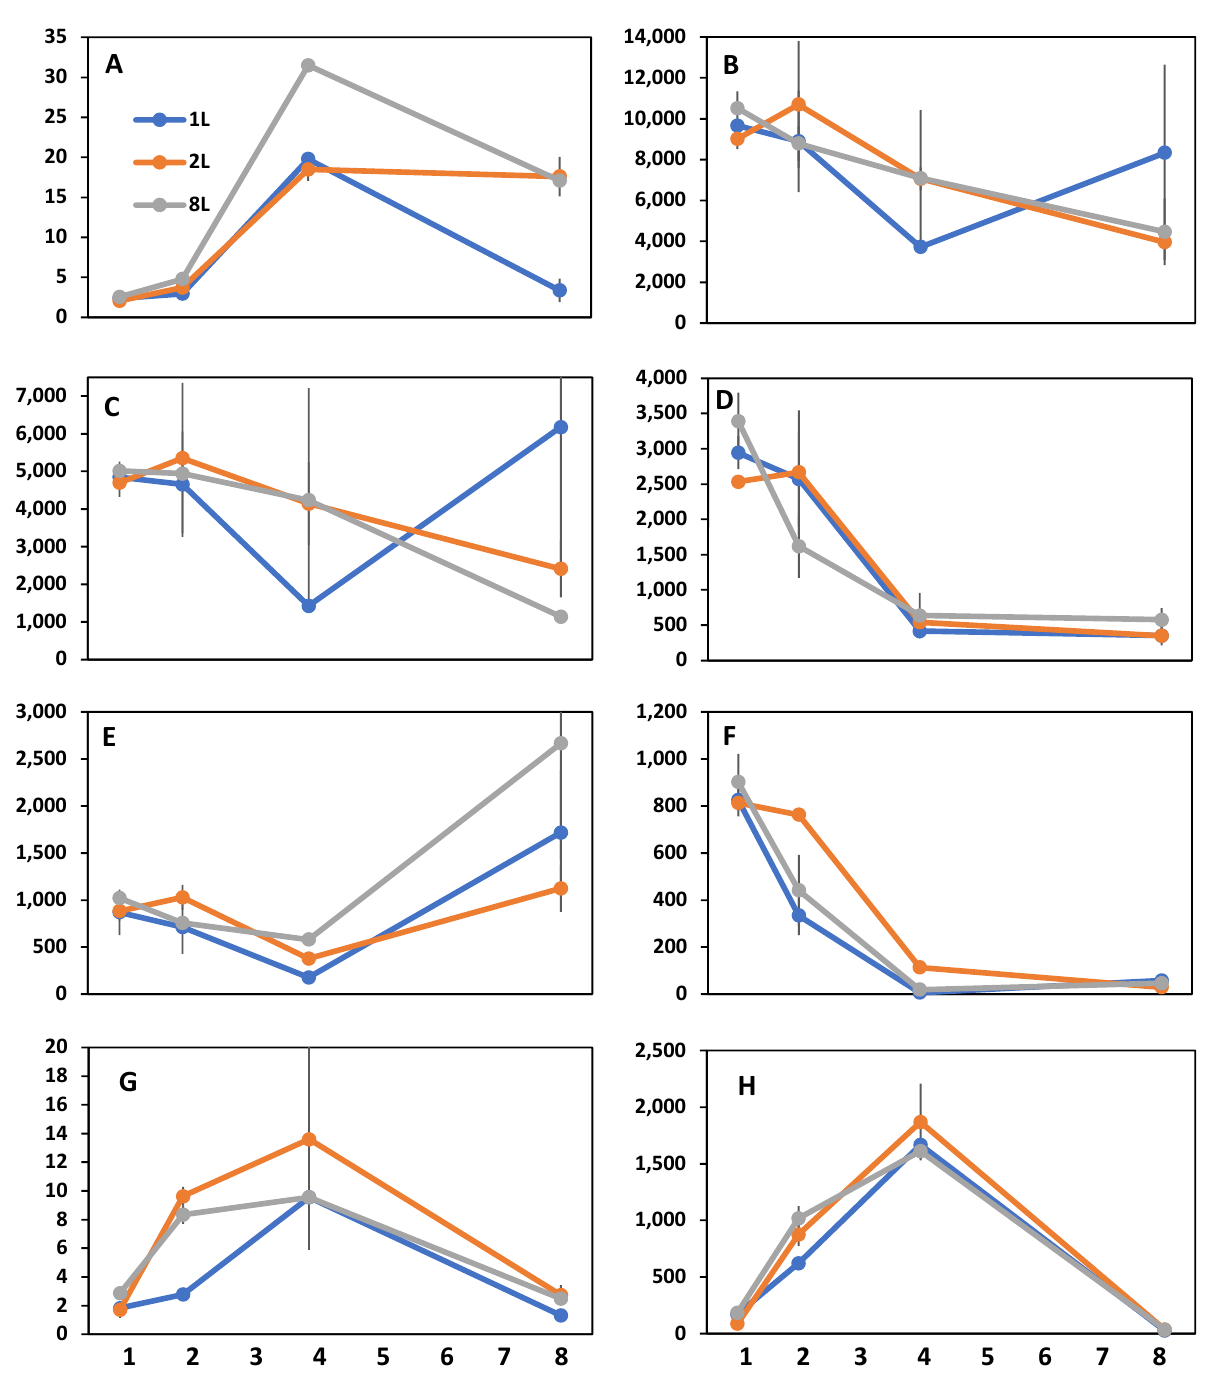
Figure 2. ( A ) Chlorophyll a concentration ( µ g L − 1 ) and ( B – H ) abundance ( × 10 4 cell L − 1 ) of phytoplankton in the autumn experiment. ( A ) Chlorophyll a concentration; ( B ) total abundance; ( C ) cyanobacteria; ( D ) eukaryotic picophytoplankton; ( E ) plastidic nanoflagellates; ( F ) cryptophytes; ( G ) dinoflagellates; and ( H ) diatoms, observed in bottles with variable volumes (1 L, 2 L, 8 L), subject to periods of incubation with the duration of 1 to 8 days. Vertical lines on each bar represent ± 1 standard error of the mean.